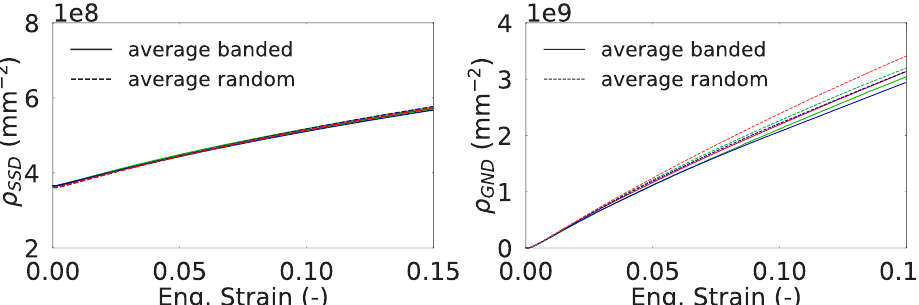
Figure 7. Distribution of ( a , d , g ) ρ SSD (mm − 2 ), ( b , e , h ) ρ GND (mm − 2 ), ( c , f , i ) Normalized dislocation density for random morphology. Three rows represent 3 different orientation sets